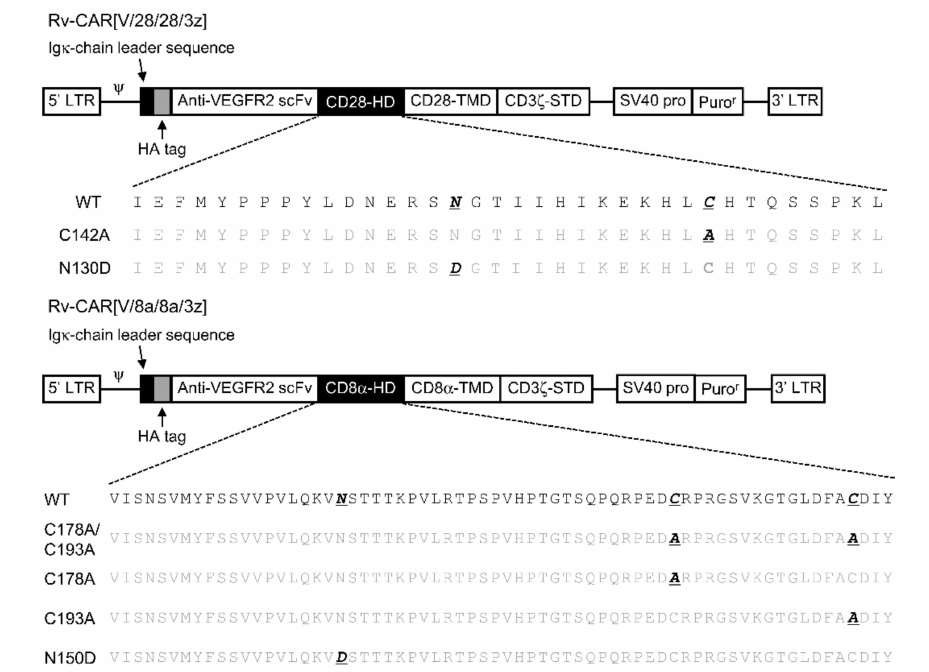
Figure 2. Illustration of the retroviral vector construct containing the gene encoding a VEGFR2- specific CAR and the amino acid sequence of the